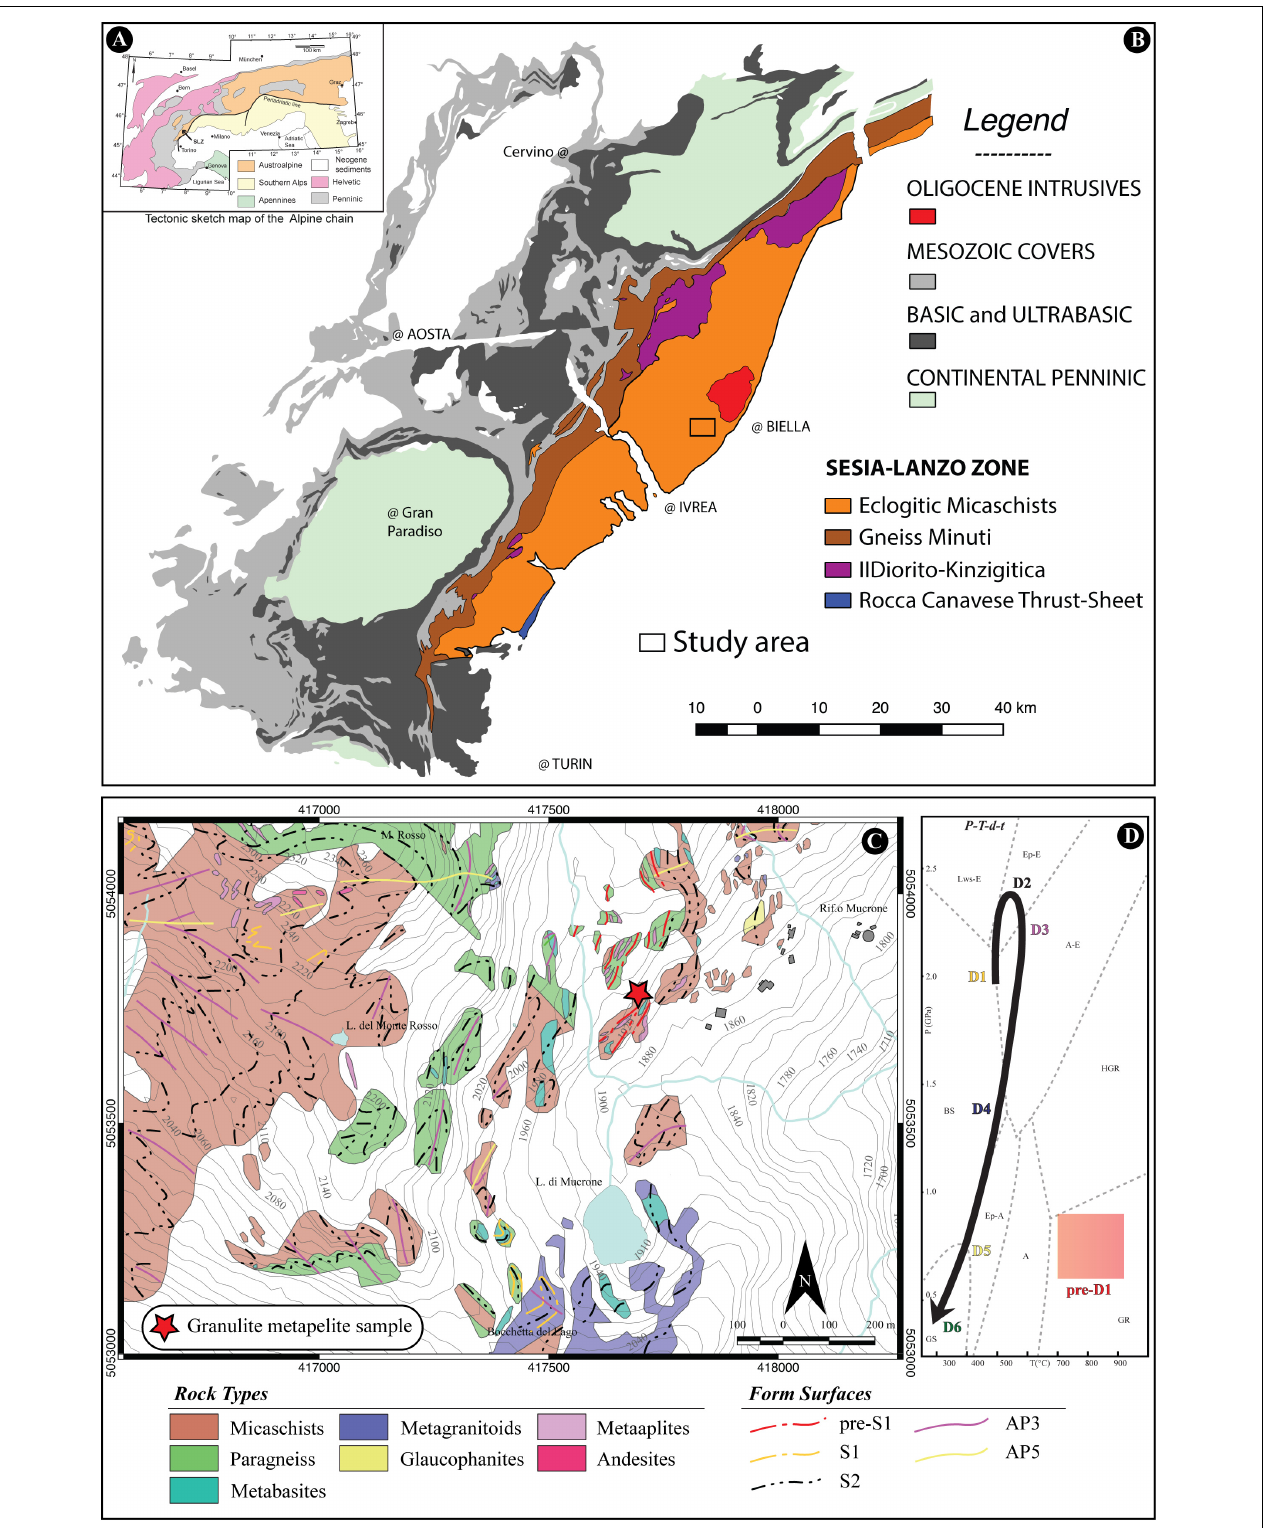
FIGURE 1 | (A) Tectonic outline of the major domain of the alpine chain. (B) Tectonic scheme of the Western Alps with the different metamorphic complexes of the Sesia-Lanzo Zone. The studied area is located. (C) Rock-types and foliation trajectories around the Mt. Mucrone. The metapelitic granulite sample is located. (D) P-T-d-t path modified after Zucali et al. (2002) and Delleani et al. (2013).